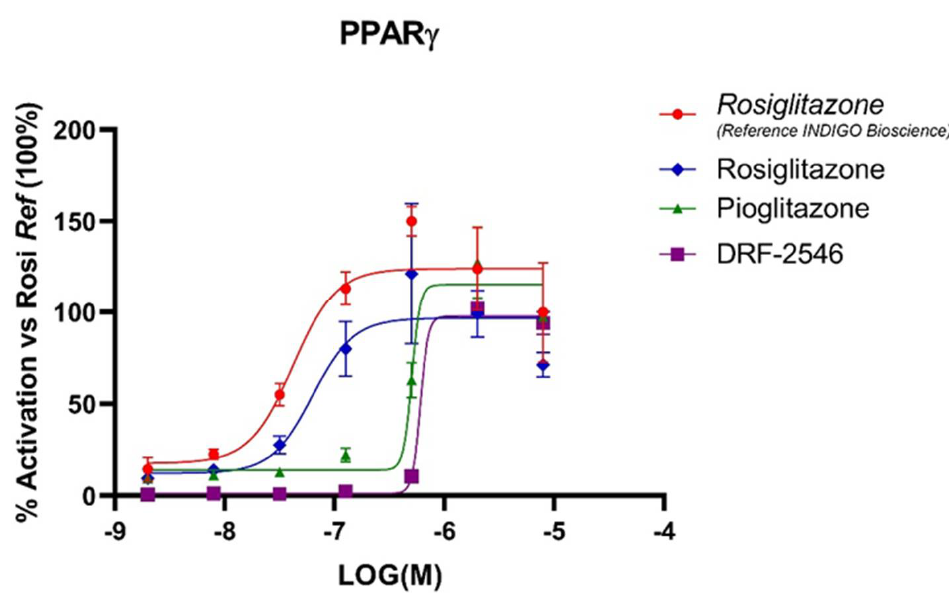
Figure 1. In vitro selectivity of different thiazolidinediones for the human peroxisome proliferator-activated receptor γ (PPAR γ ). Results are shown as the percentage activation of each thiazolidinedione with respect to the reference compound (rosiglitazone from Indigo Biosciences).